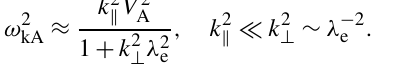
Figure 3. Two oppositely directed electron-scale current sheets with current J (cid:107) (yellow) flowing along the guide magnetic field in the case that B g > B 0 is stronger than the magnetic field B ≡ B 0 (light- blue vectors) of the guide-field-aligned current. The currents close via J ⊥ somewhere in a dissipative layer (red) where they are al- lowed to flow perpendicular to the field. The width of the guide- field-aligned current sheets is assumed to be narrow, the order of the electron inertial length which would allow the current magnetic field B 0 to reconnect across the current